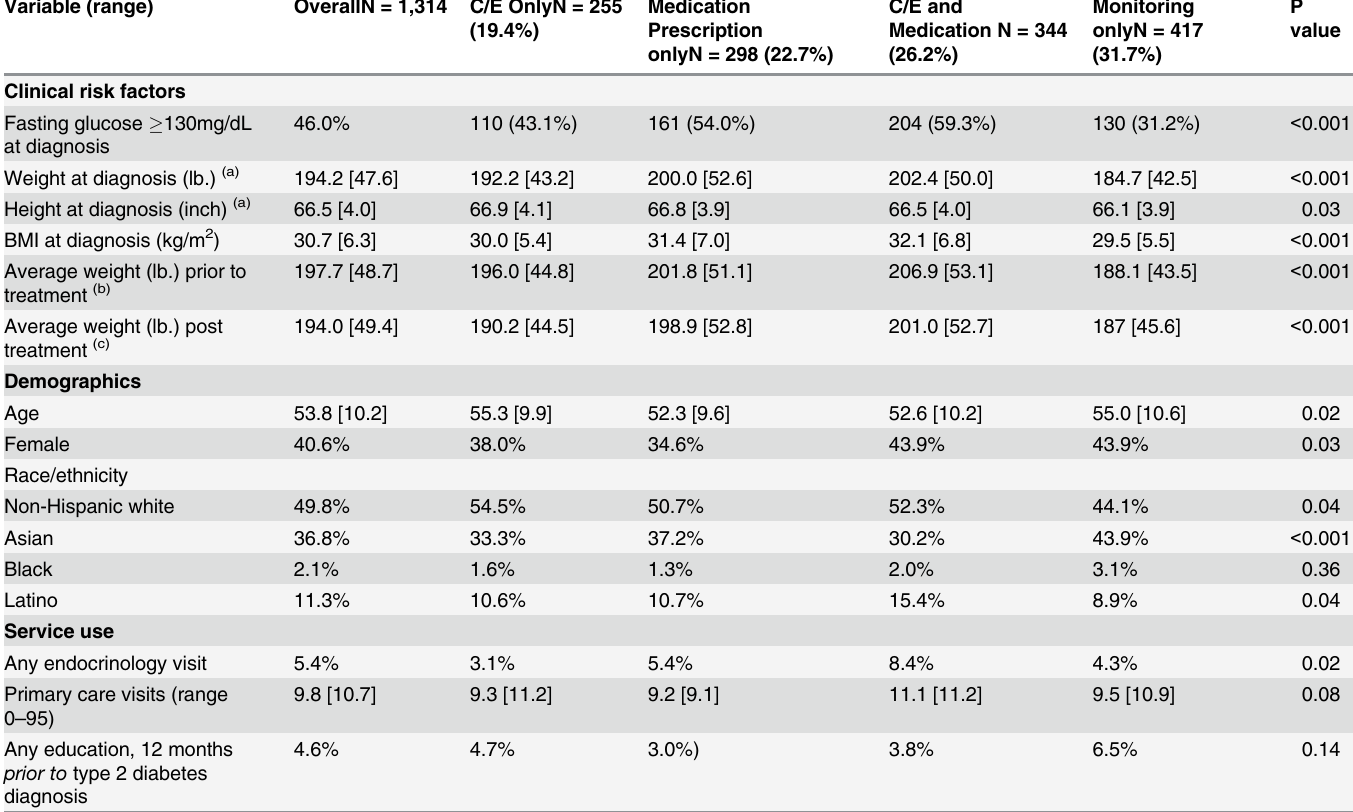
Table 1. Comparison of Clinical Characteristics at Initial Type 2 diabetes Diagnosis, by Treatment Type during 12 Months Post-Diagnosis Follow- up. Variable